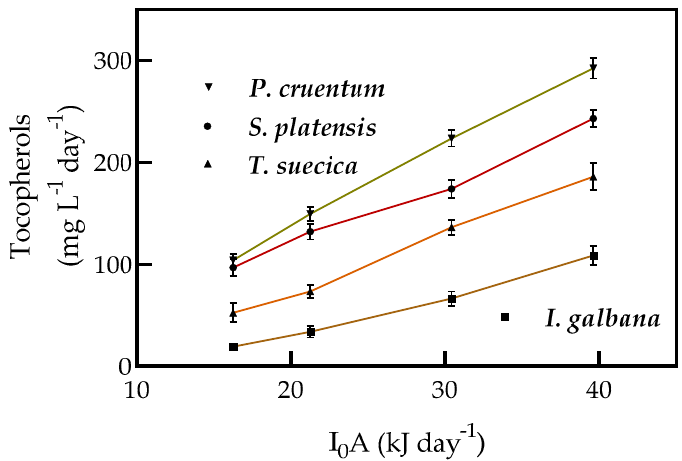
Figure 6. Tocopherols productivity in continuous cultures. Tocopherols productivity by S. platensis , I. galbana , T. suecica , and P. cruentum in continuous culture with different supplied light intensities (16.27, 21.26, 30.42, and 39.63 kJ d − 1 ). Each point represents the mean of 3 replicates ( p < 0.05).